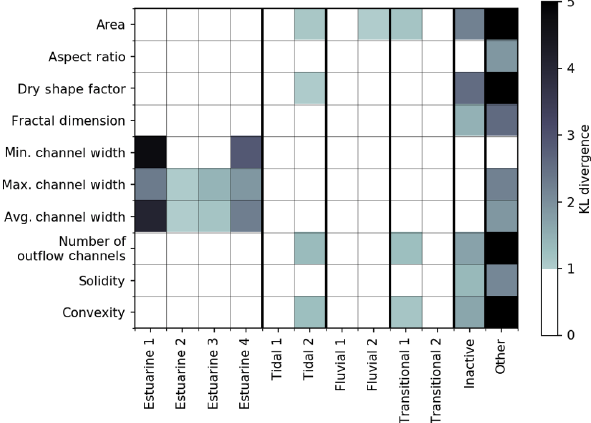
Figure 9. Kullback–Leibler divergence between the distribution of parameter values for islands of each class and all other islands for each variable. A value greater than 1 indicates that the variable dif- ferentiates the population of islands in that class from those in other classes. A value less than 1 shows that the distribution of values of that variable for that island class is similar to values for other